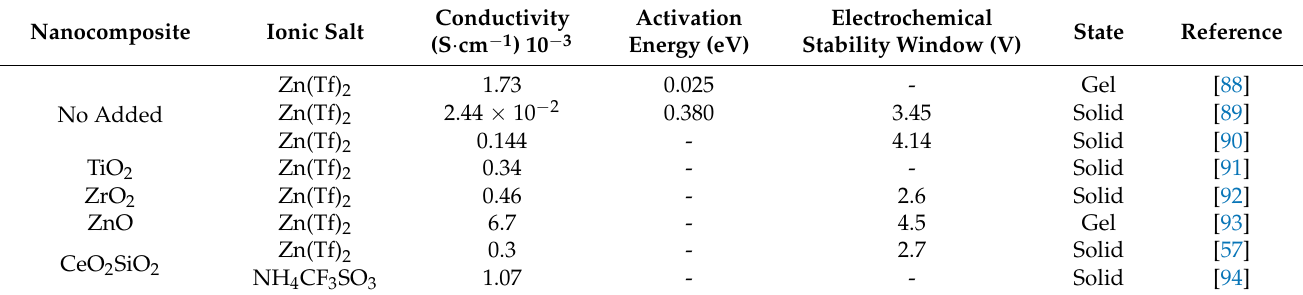
Table 2. A summary of NCPEs composed of PVDF-co-HFP for zinc